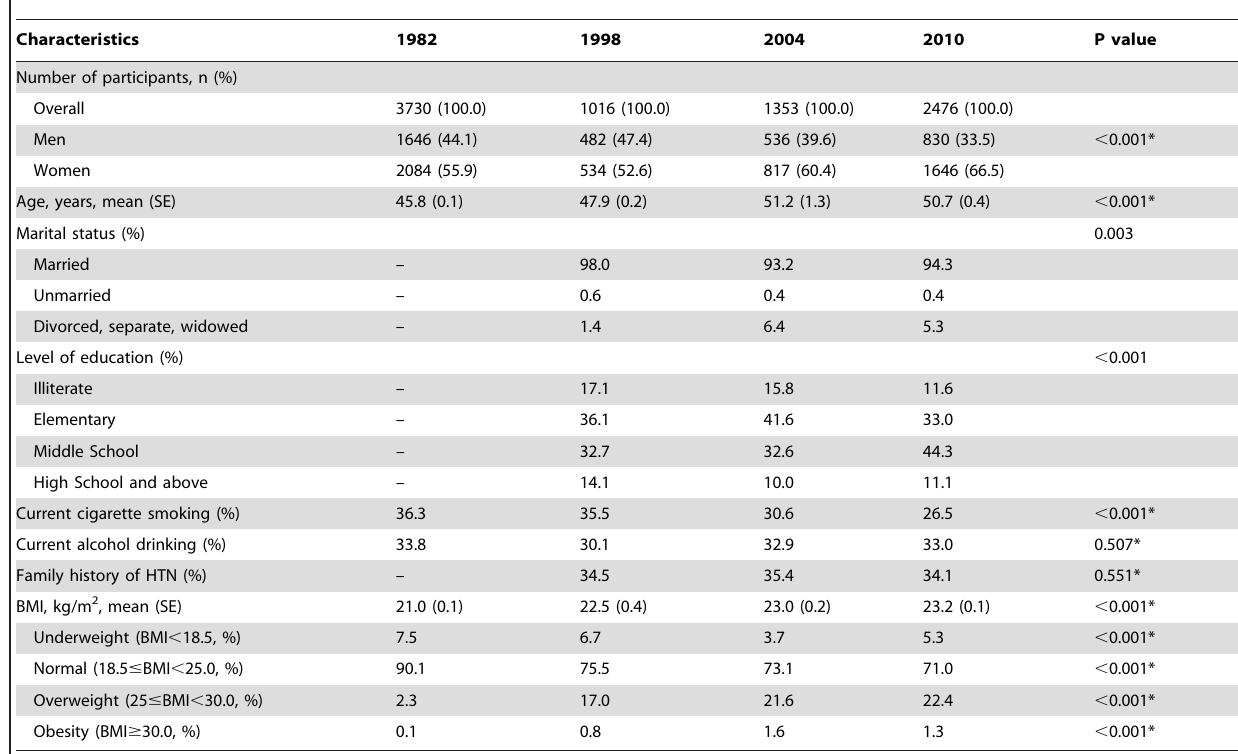
Table 1. Characteristics of the population in the